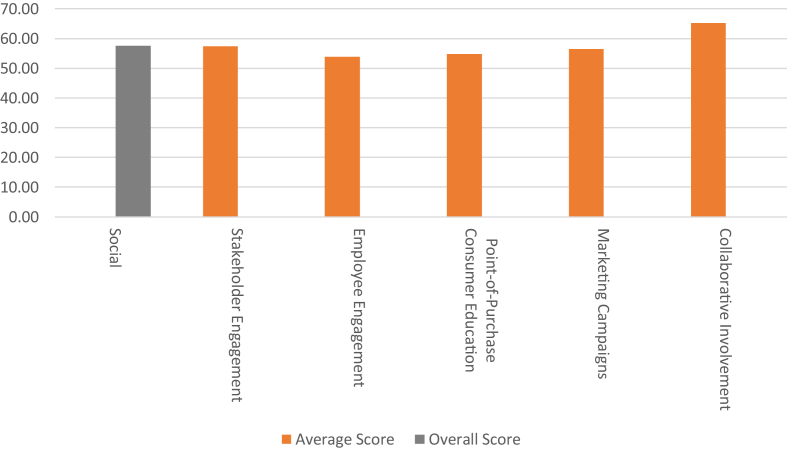
Social (SO) dimension.